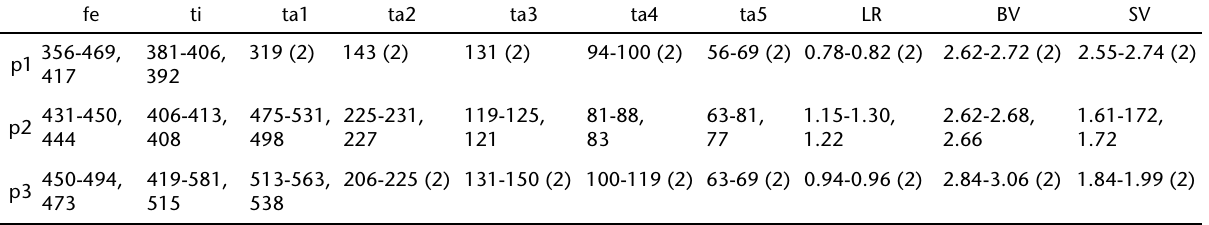
Table I. Lengths (in µm) and proportions of legs of L. tenata , male.